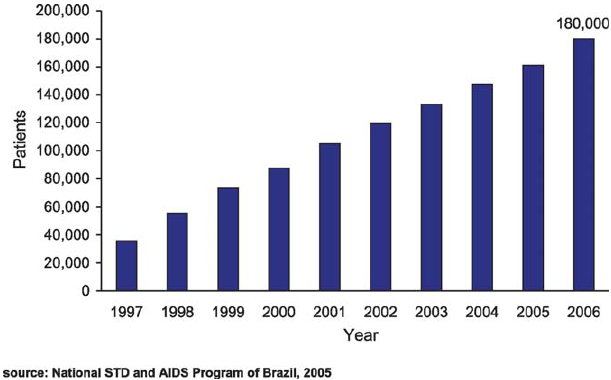
Figure 1. Patients Receiving HAART in Brazil,